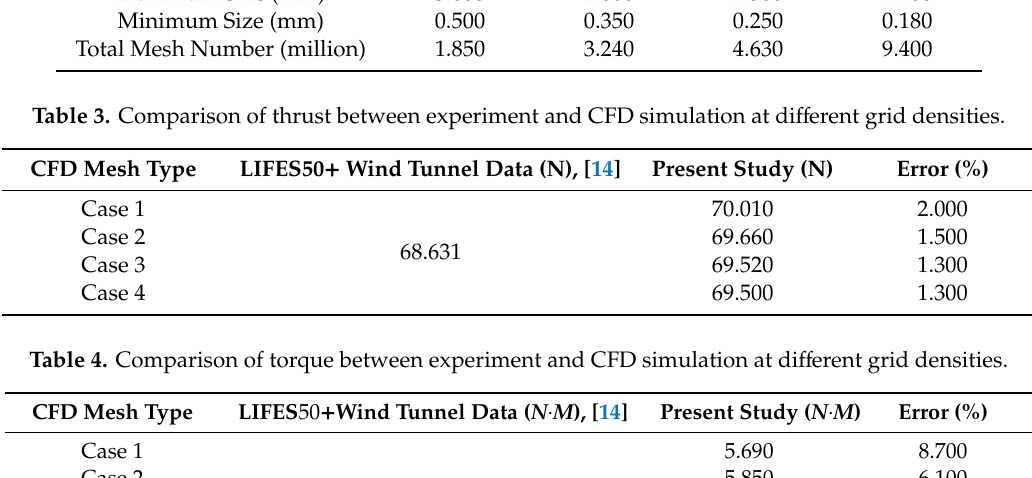
Table 3. Comparison of thrust between experiment and CFD simulation at different grid densities.